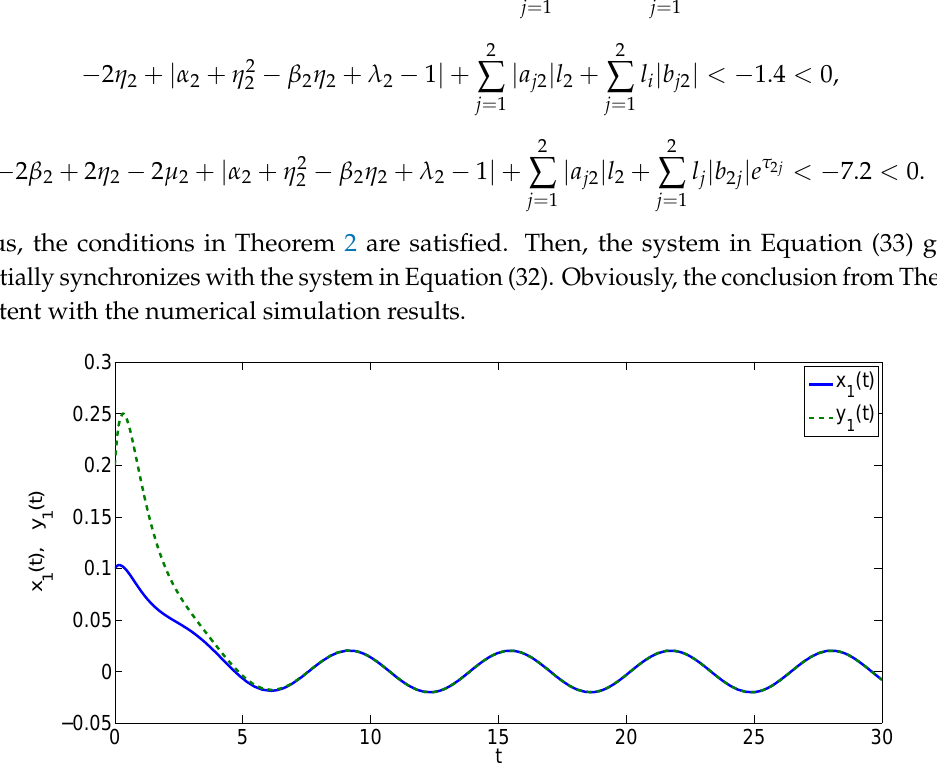
Figure 4. The synchronization trajectories between the state x 1 ( t ) of the drive system in Equation (32) and the state y 1 ( t ) of the response system in Equation (33) in Example